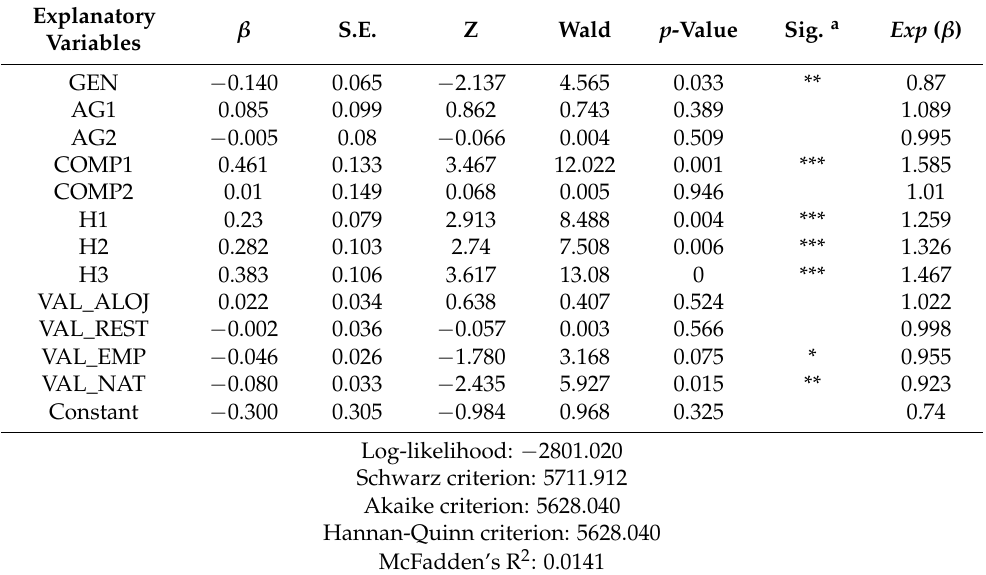
Table 2. Estimation of the binary logistic regression model (1). Explanatory